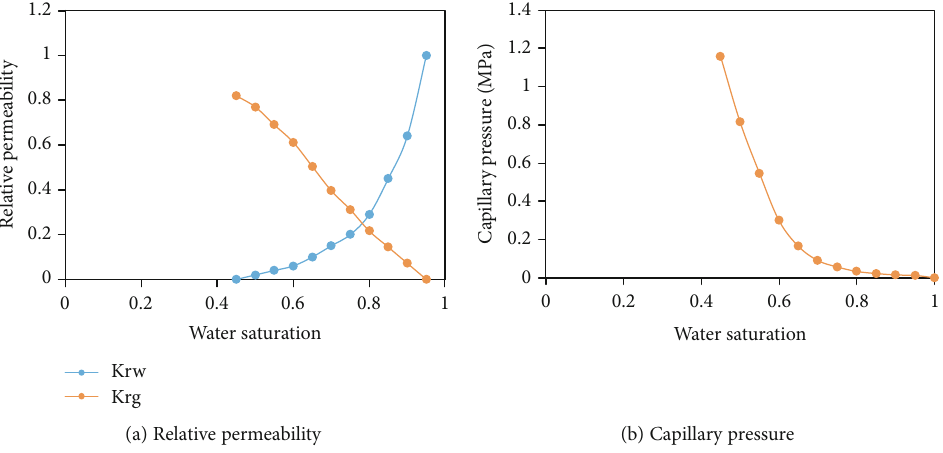
Figure 4: The relative permeability and capillary pressure of coal.